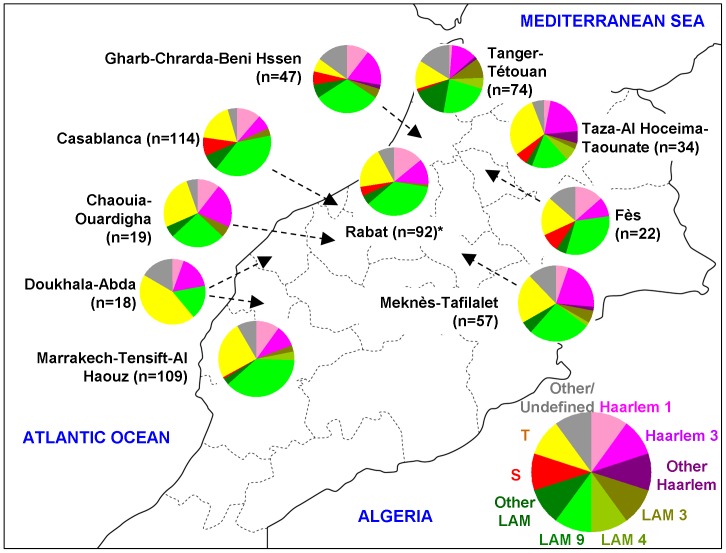
Geographical distribution of genotypic lineages of M. tuberculosis isolates from Morocco among ten distinct administrative regions (n = 586/592 strains; 6 strains from 3 cities were not shown as pie charts due to their low numbers: Oujda n = 1; Inezgane n = 2; Ouarzazate n = 3).Asterisk (*) denotes the administrative region of Rabat-Salé-Zemmour-Zaër). The references to color and lineages in this figure are as follows: (i) Haarlem1: SITs 47, 62, 143, 218, 609, 1139, 1155, 2333, 2567, 2 orphans; (ii) Haarlem3: SITs 36, 49, 50, 433, 741, 1135, 1539, 2338, 3077, 3078; (iii) Other Haarlem genotypes: Haarlem2 (SIT2), and Haarlem (1 orphan); (iv) LAM3: SITs 33, 105, 106; (v) LAM4: SIT60, 163, 1 orphan; (vi) LAM9: SITs 42, 161, 162, 177, 492, 731, 737, 770, 822, 866, 1070, 1074, 1075, 1154, 1277, 1832, 1 orphan; (vii) Other LAM genotypes: LAM1 (SITs 964,2372), LAM5 (SITs 93, 1072, 1999,2341), LAM6 (SIT64), LAM10-CAM (SIT61), LAM12-Madrid (SIT209), LAM (SITs 1537,3075, 7 orphans); (viii) S lineage: SIT34, 466, 784, 2516; (ix) ill-defined T: SIT7, 31, 32, 37, 40, 44, 53, 58, 65, 73, 77, 78, 102, 120,164, 244, 291, 334, 373, 751, 926, 1069, 1105, 1580,1626, 1655, 2025, 3073, 3076, 6 orphans; (v) and Other/undefined: these included Beijing (SIT1), CAS1-Delhi (SIT26), BOV_1 (SIT481, 1026), BOV_4-CAPRAE (SIT644), as well as other undefined profiles marked as Unk (unknown) in Table S1.